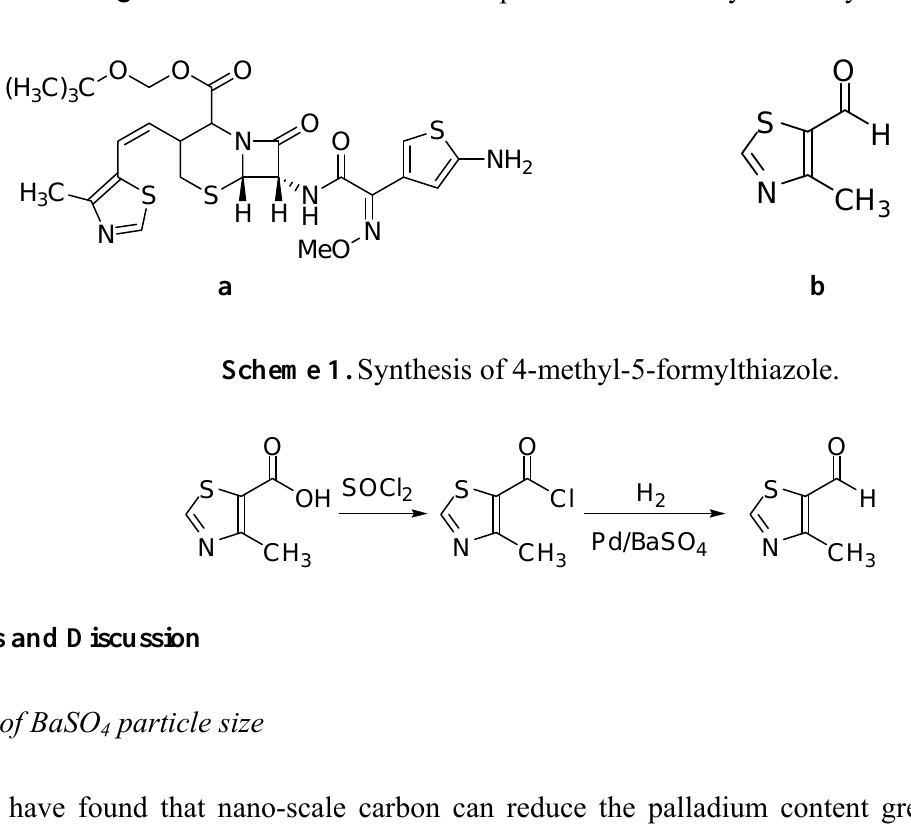
Figure 2 Effect of Pd/BaSO